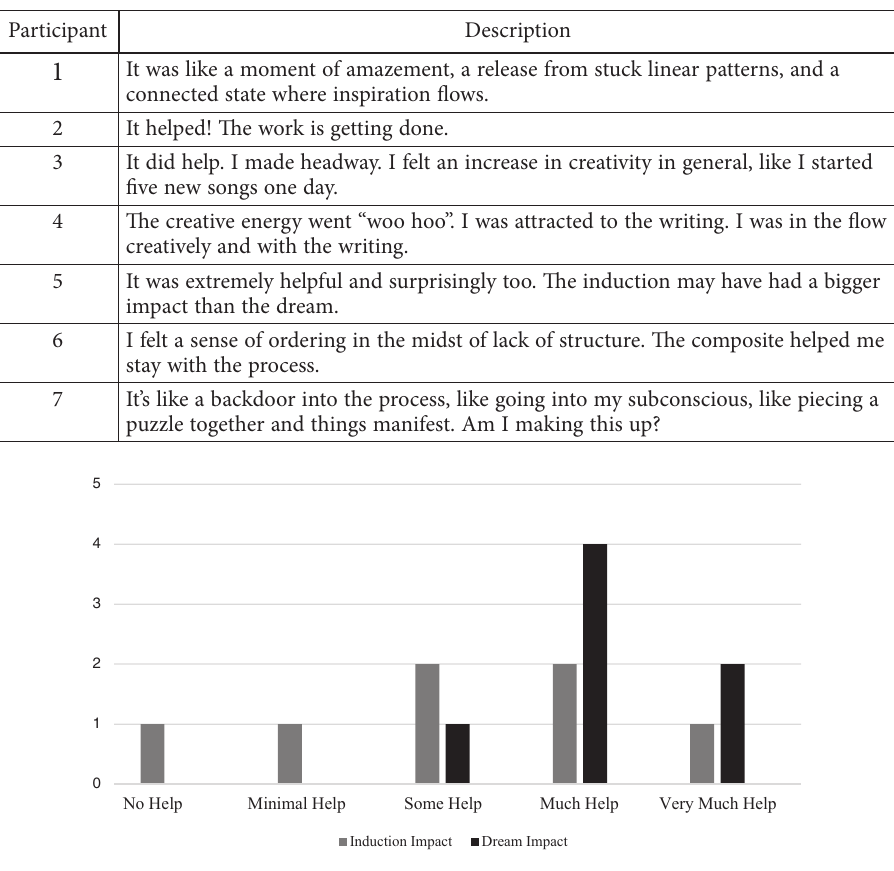
Table 3. Participants’ descriptions of embodied imagination impact on creative process (after ses- sion 2) (source: created by author) Participant Description